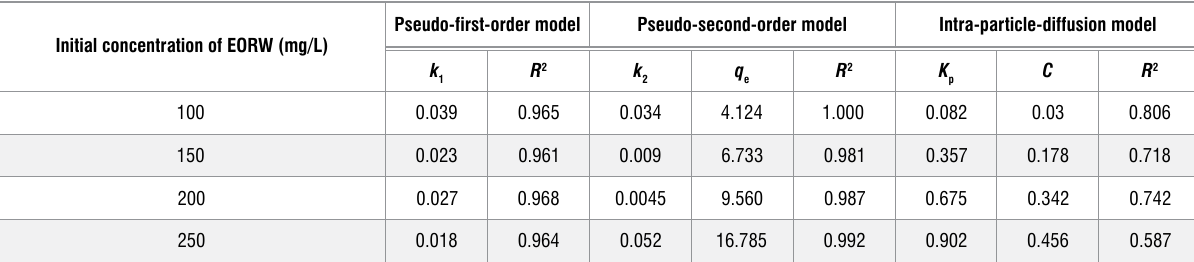
Table 2: Constant parameter values for the photocatalytic degradation kinetics of edible oil refinery wastewater (EORW) Pseudo-first-order model Pseudo-second-order Initial concentration of EORW (mg/L)